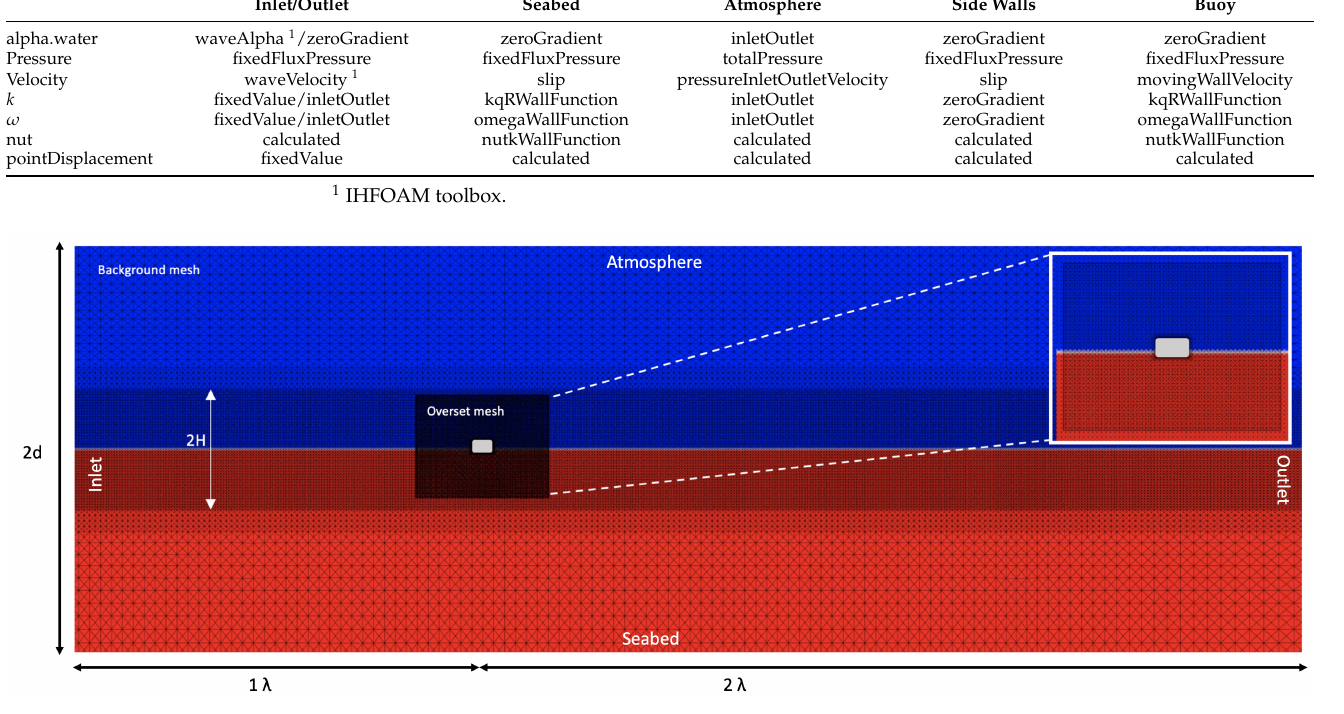
Figure 4. Schematic depiction of the numerical wave tank in the xz plane, with the dimensions and boundaries labelling. The letters d , λ , and H denote the water depth, wave length and wave height, respectively. The background and overset mesh regions, and the boundaries’ labelling are shown. The region of higher mesh resolution close to the water surface and around the buoy captures the wave propagation and the dynamic and turbulence effects,